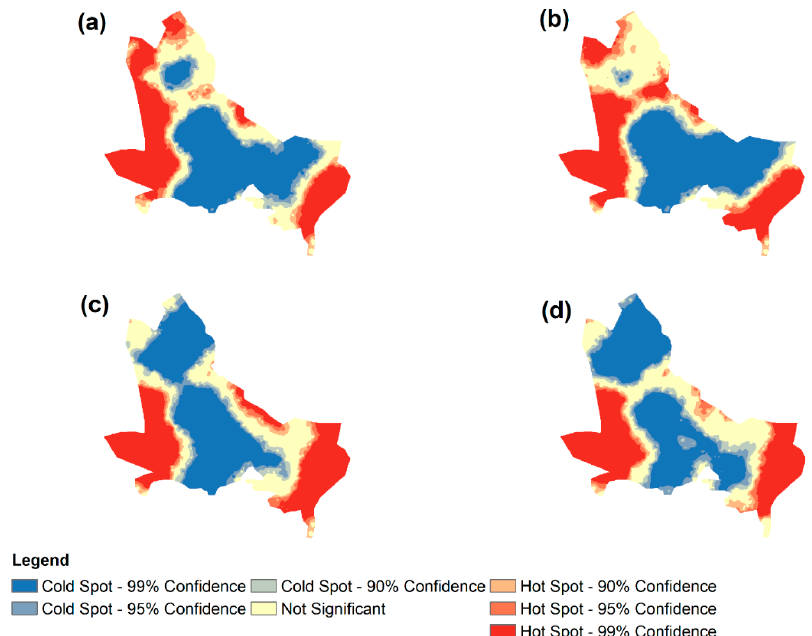
Figure 7. Change in hot and cold spots’ spatial patterns for LST during ( a ) 1990, ( b ) 2000, ( c ) 2010, and ( d ) 2020.